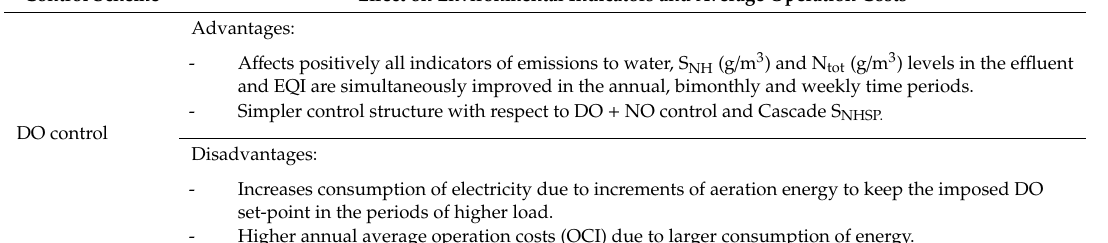
Table 15. Summary of the e ff ect on dynamic evolution of environmental indicators and average operation costs of the three evaluated proportional integral (PI) control schemes (DO control, DO + NO control, Cascade S NHSP ). Control